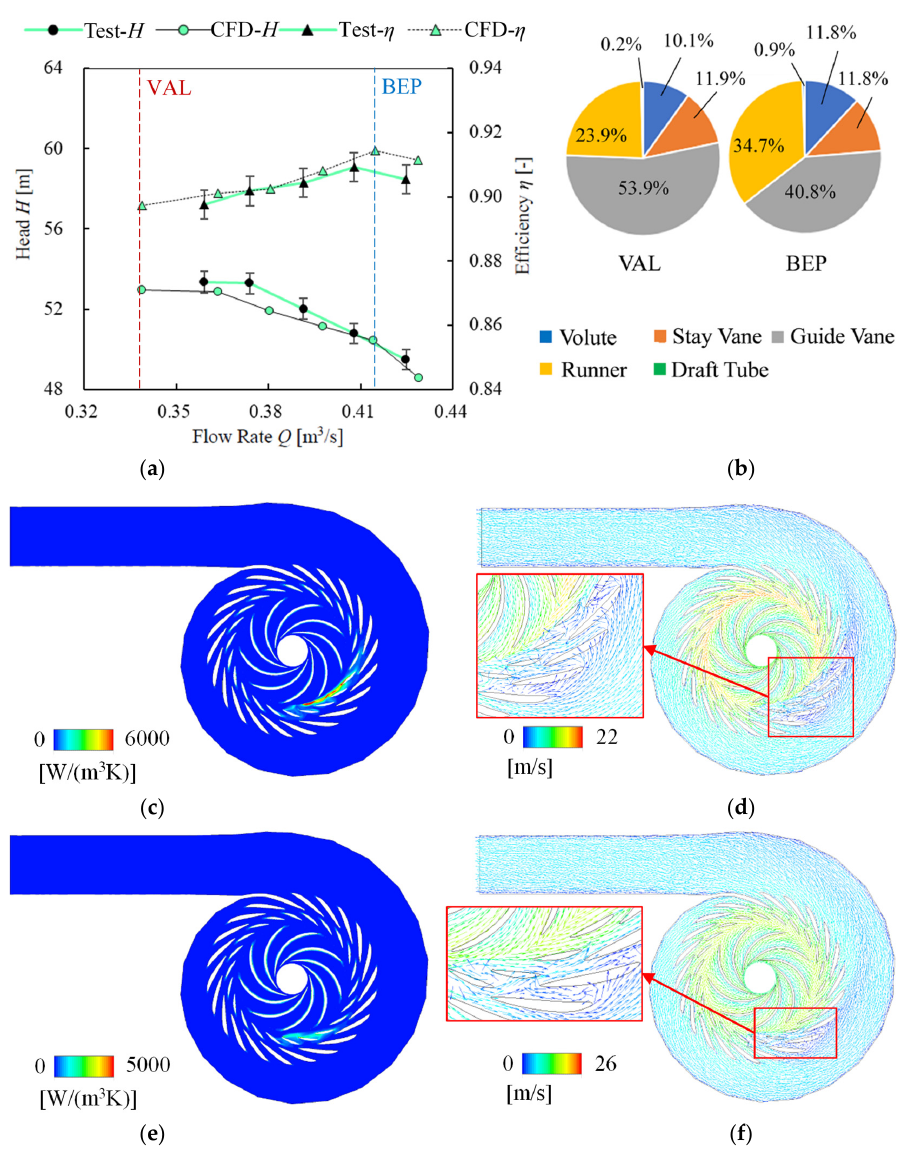
Figure 6. Performance curve and flow pattern at 18° attack angle. ( a ) Q-H and Q- η curve; ( b ) pro- portion of flow energy loss; ( c ) VAL S pro ; ( d ) VAL v ; ( e ) BEP S pro ; ( f ) BEP v ; VAL: local valley of Q-H curve; BEP: best efficiency point.